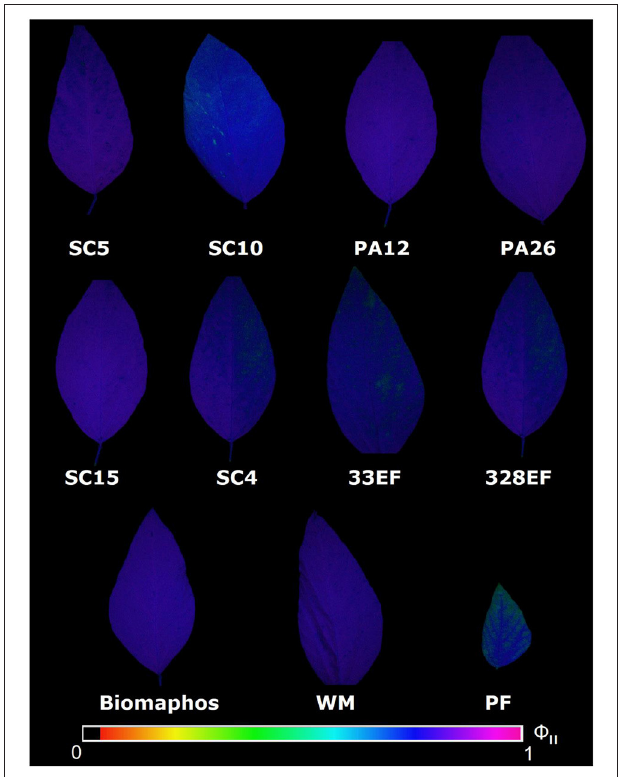
FIGURE 6 | Fluorescence images of chlorophyll- a obtained for the effective quantum yield of photochemical energy conversion in PSII ( 8 II) in leaves of Glycine max grown in nutrient solution providing calcium phosphate (CaHPO 4 ) as a phosphate source and inoculated with four bacterial strains and four fungal strains. SC5, Bacillus cereus ; SC10, B. thuringiensis; PA12, Paenibacillus alvei ; PA26, Lysinibacillus fusiformis ; SC15, Penicillium sheari ; SC4, Epicoccum keratinophilum ; 33EF, Hamigera insecticola ; 328E, Codinaeopsis sp.; Biomaphos ® , B. megaterium and B. subtilis ; WM, without microorganisms; PF, phosphorus-free.